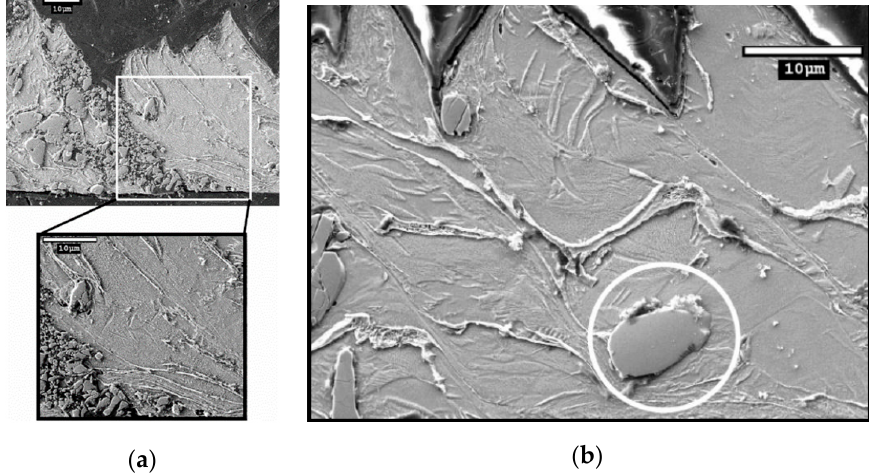
Figure 3. ( a ) Particle broken into many other smaller particles during the chip formation at v c = 60 m/min; ( b ) Unbroken particle during the chip formation at v c = 180 m/min [32].